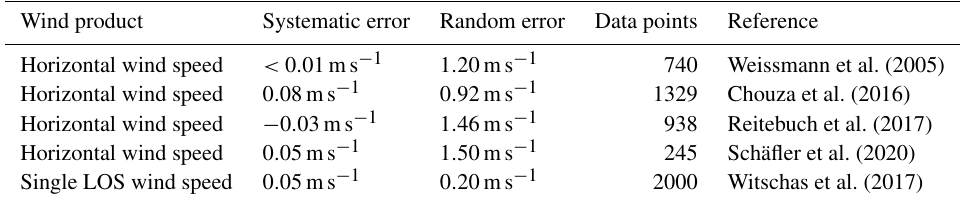
Table 2. Systematic and random error of 2µm DWL wind speeds determined by comparison to dropsonde measurements and power spectrum analysis of 2µm DWL horizontal and LOS wind